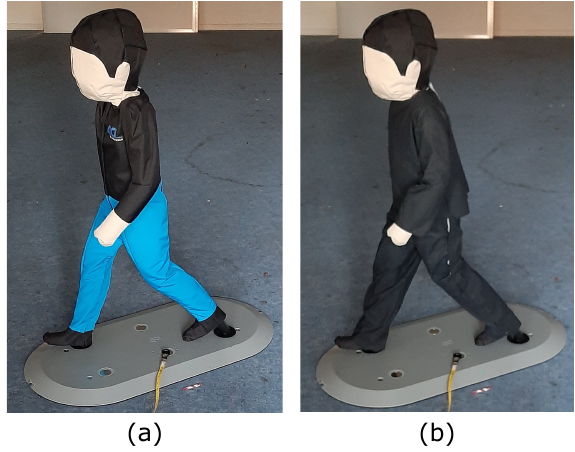
Figure 4. This figure presents in part ( a ) the test target defined in the standard ISO 19206-2:2018-12 [19] and in part ( b ) the modified test target with optical requirements of the standard ISO 3691-4:2020- 02 [20] by the authors. Reprinted from Ref.